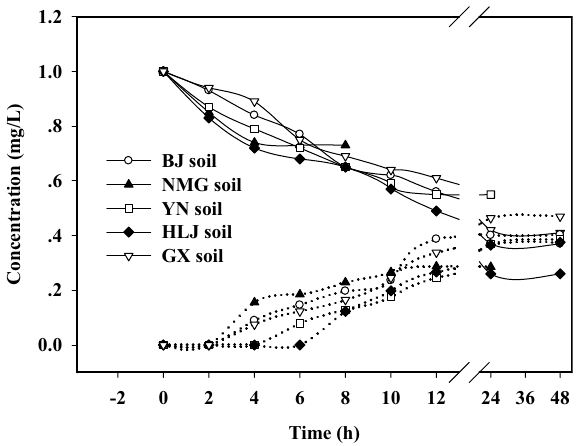
Figure 1. Adsorption–desorption kinetics of QUN in soils.